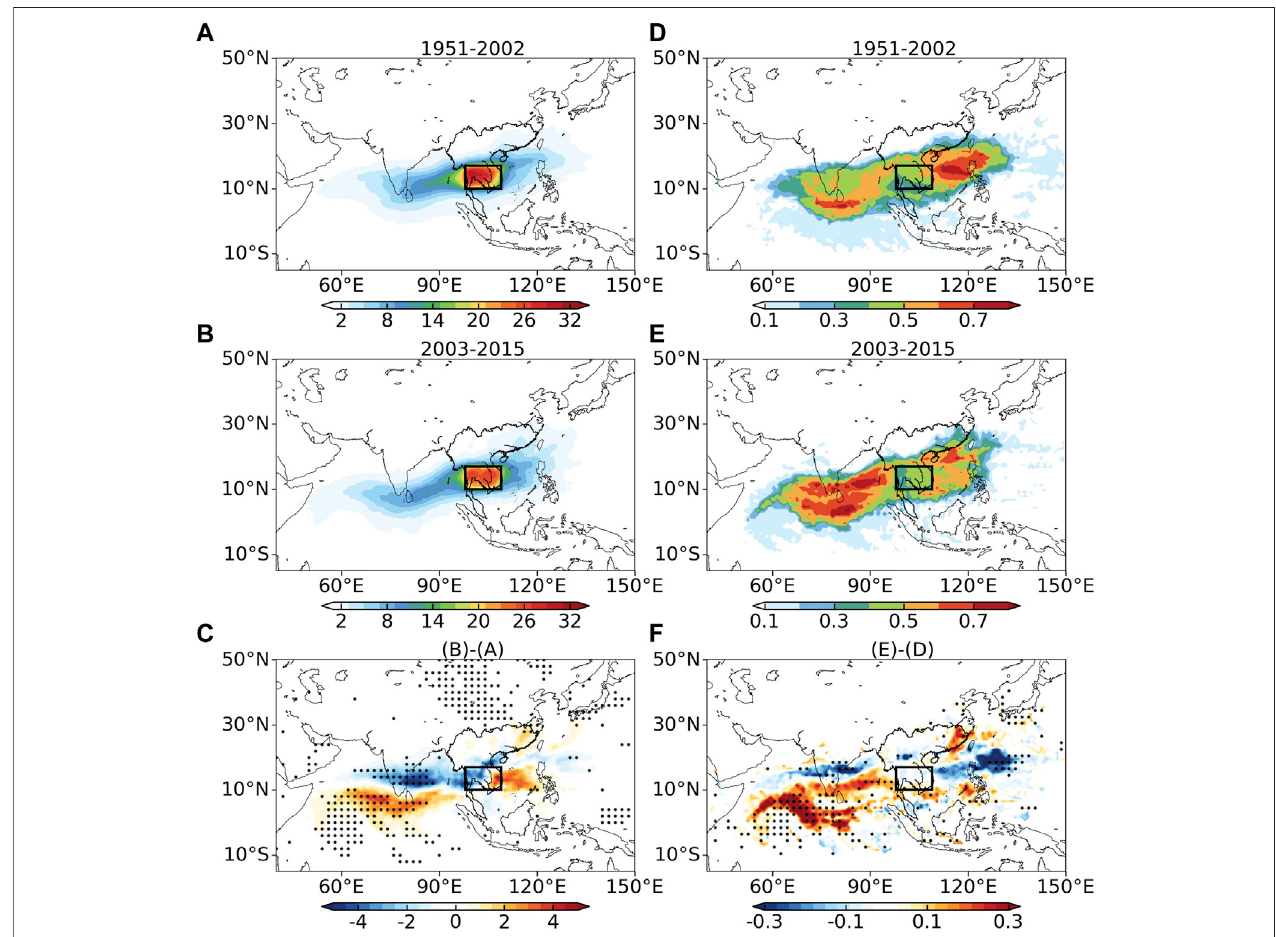
FIGURE 5| Trajectory density patterns for the extreme precipitation during (A) 1951 – 2002, (B) 2003 – 2015, and (C) their differences. (D – F) asin (A – C) but for the PSCF. Only differences that are statistically signi fi cant at the 90% con fi dence level are stippled in (C , F) .